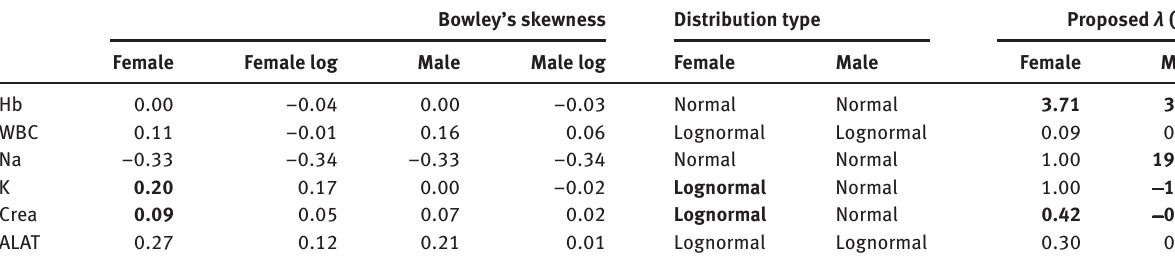
Table 1: Bowley skewness (left) and proposed λ for power transformation (right) of routine laboratory